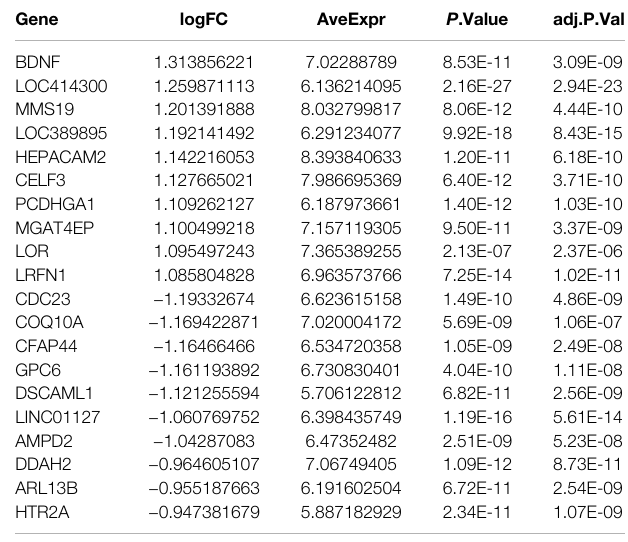
TABLE 2 | The top 10 upregulated and downregulated DEGs between cluster 1 and cluster